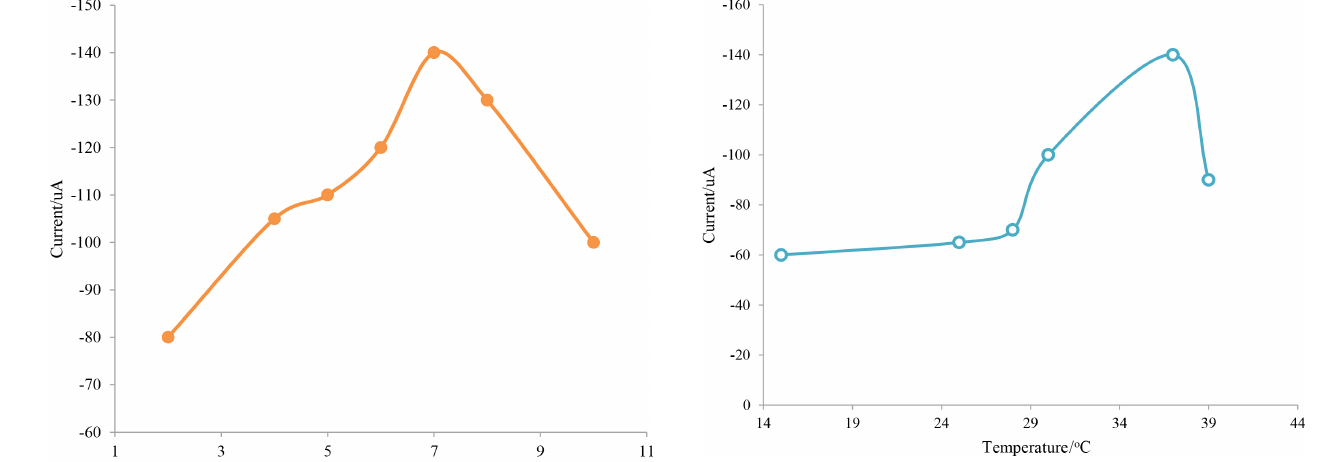
Figure 9. pH effect on Aeromonas hydrophila DNA biosensor re- sponse in pH range 2–10; optimum pH7.